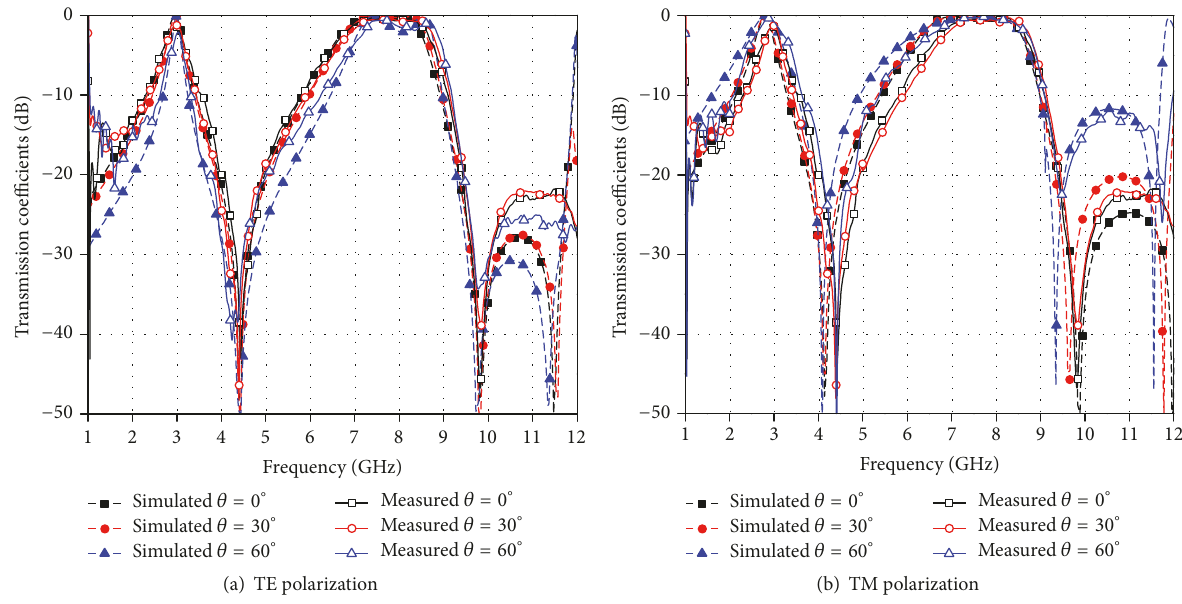
Figure 11: Measured and simulated transmission coefficients of the dual-band FSS for oblique incident angles from 0 ∘ to 60 ∘ . (a) TE polarization. (b) TM